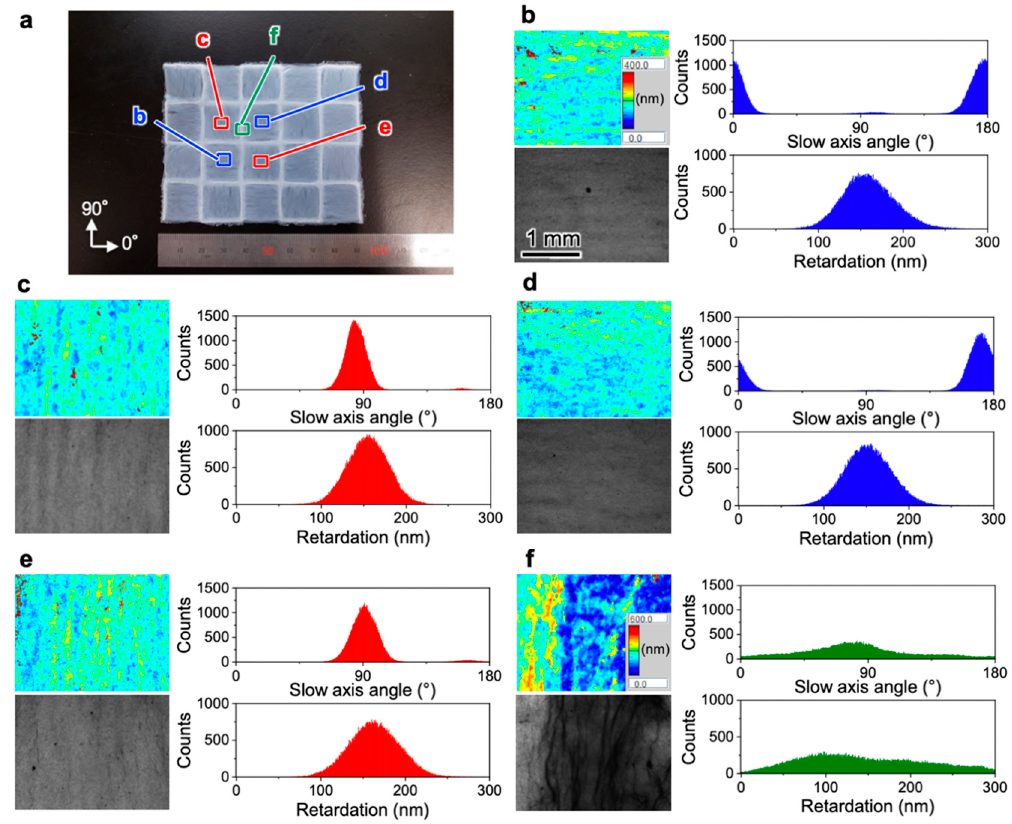
Figure 4. Local retardation of the checkered film of multiaxis oriented TNWs. ( a ) Location and angle definition for the retardation measurements in ( b – f ); ( b – f ) 2D retardation maps (upper left panel), brightness images (lower left panel), slow axis angle distributions (upper right panel), and retardation distributions (lower right panel). The color scales of the retardation maps for ( b )–( e ) and ( f ) correspond to the inserts in the upper left panels of ( b ) and ( f ), respectively. All of the scales of the retardation mappings and brightness images correspond to the scale of the lower left panel in ( b ).